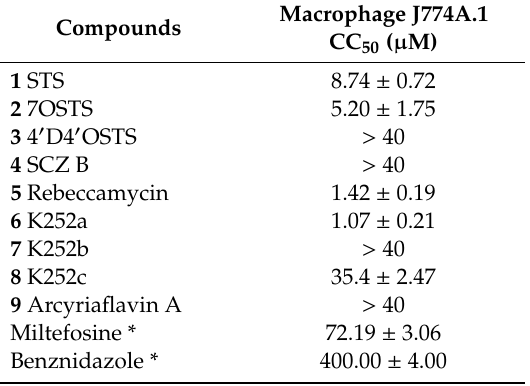
Table 2. Toxicity against murine macrophage J774A.1 (CC 50 ) measured by AlamarBlue assay. CC 50 are reported in µ M concentrations. (Mean concentration ± SD).